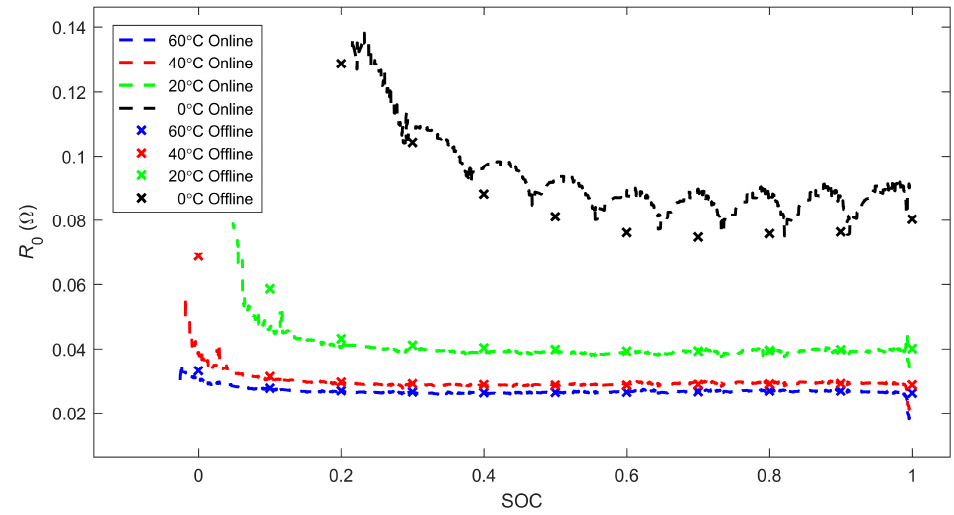
Figure 5. Comparison of online and offline parameters identification.